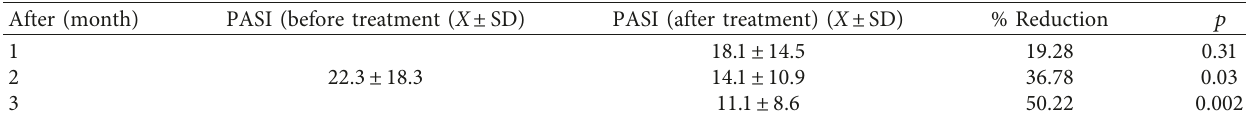
Table 4: Treatment outcome of the control group ( n � 31).